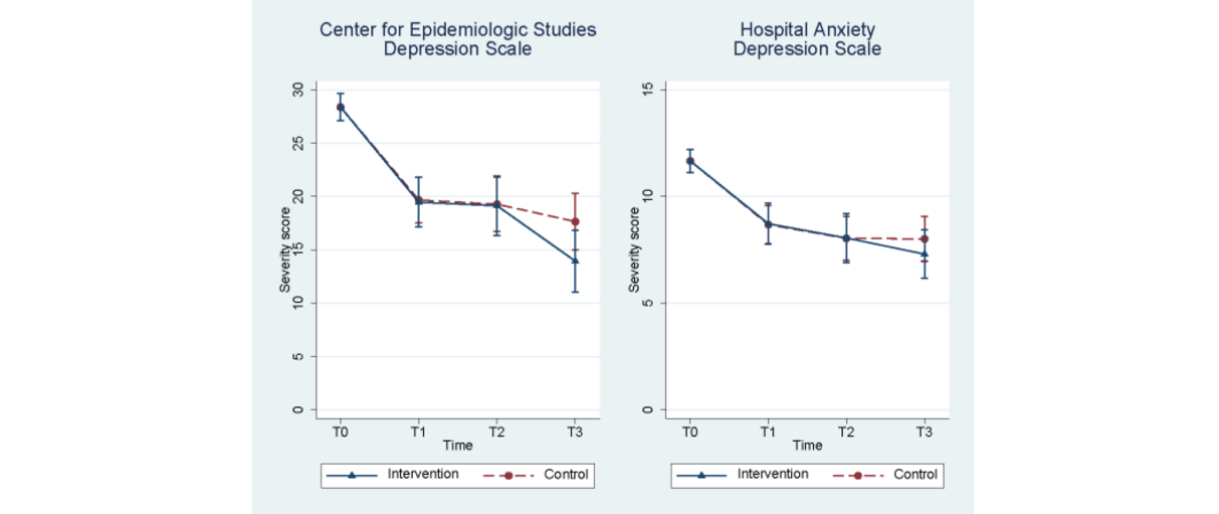
Figure 2. Predicted Center for Epidemiological Studies Depression and Hospital Anxiety and Depression Scale severity scores (primary outcomes) estimated using linear mixed models correcting for baseline differences. Measurements taken at T0: baseline; T1: 10 weeks after baseline; T2: 4 weeks before the expected date of delivery; T3: 6 weeks